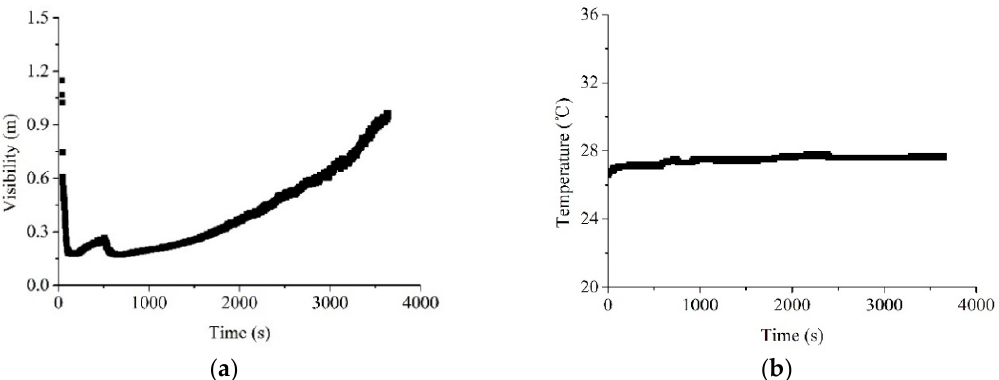
Figure 10. Visibility ( a ) and temperature ( b ) histories for the smoke produced by smoke cake.